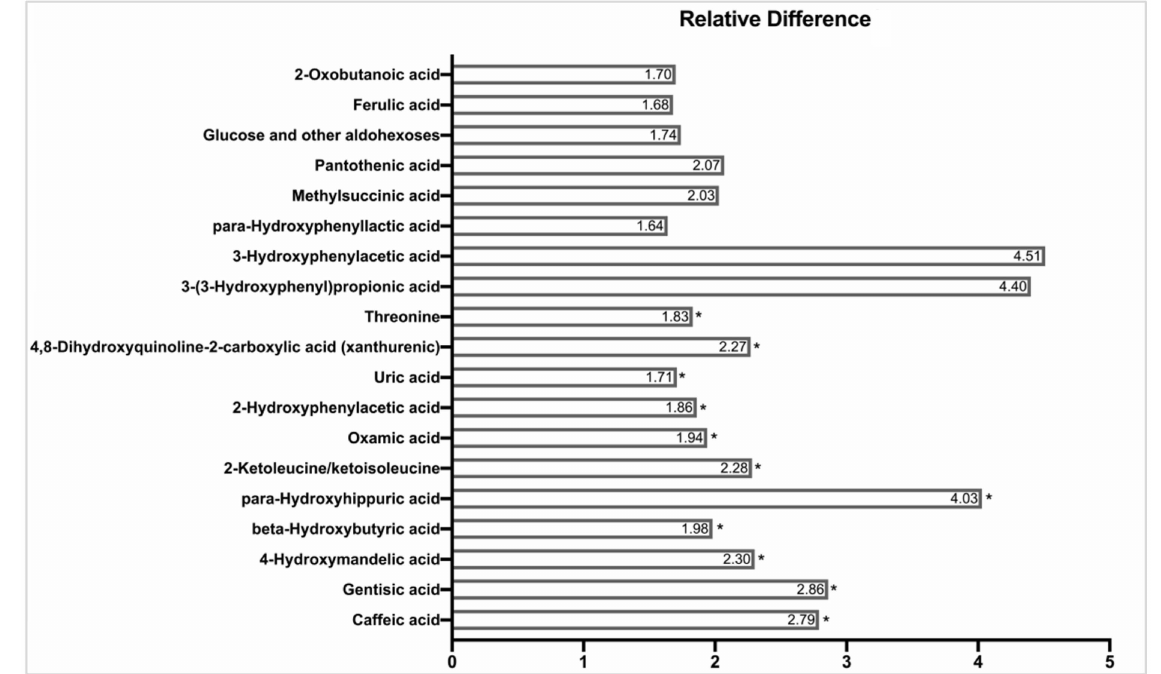
Figure 2. Relative Difference in Nominally Significant Metabolites from Untargeted Urine GC/MS during Randomized DASH and Control Feeding Periods. Relative difference represents the ratio of peak areas by GC/MS. Differences are tested using generalized estimating equation models evaluating the difference in log 2 peak areas in non-missing samples obtained during randomized study weeks on either DASH or Control diet. Relative differences re-express absolute log 2 difference coefficients ( β ) as 2 β . Significance at a false discovery rate (FDR) adjusted p < 0.20 is indicated by an asterisk (*). Metabolites are ordered by statistical significance with the most statistically significant metabolites beginning at the bottom near the x -axis. Several metabolites had between 10–20 imputed values including caffeic acid, gentisic acid, uric acid and